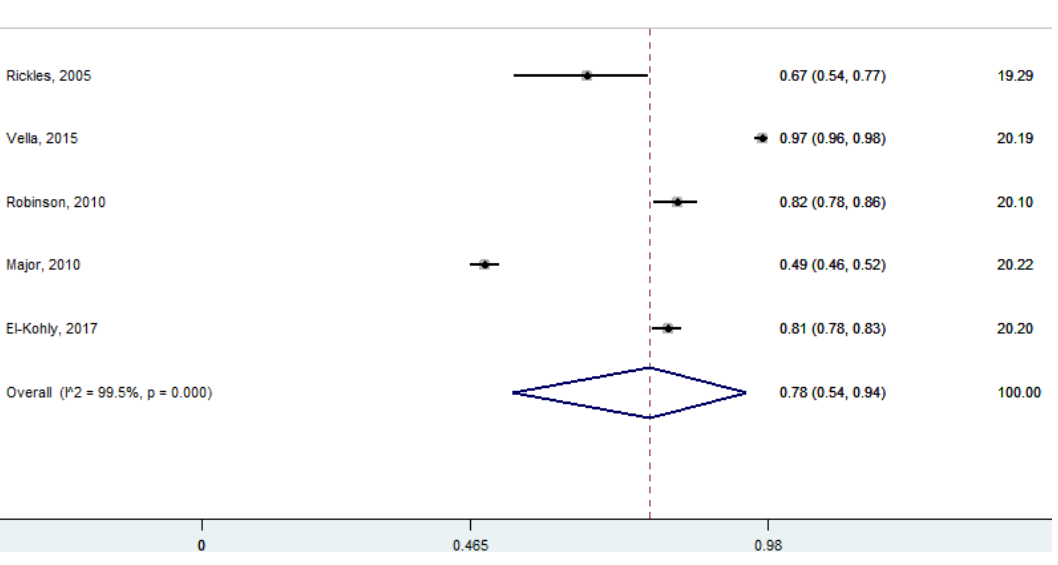
Figure 2. Effective interaction between patients and the community pharmacists (five studies).